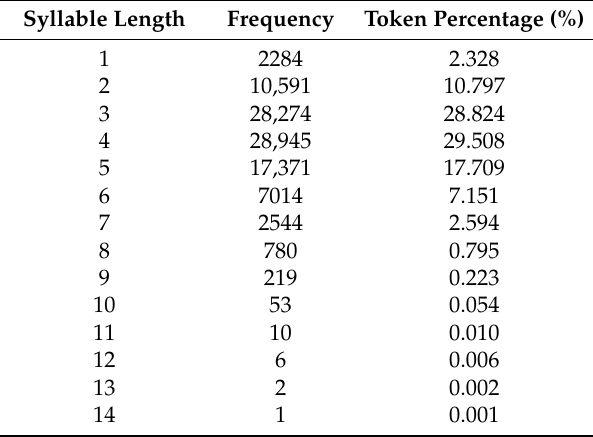
Table 2. Syllable 1